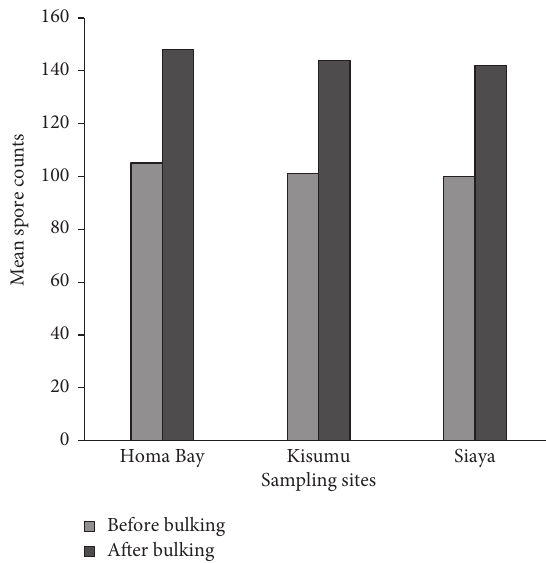
Figure 2: Mean number of AMF spores per 50g of soil sample from the sampling sites.